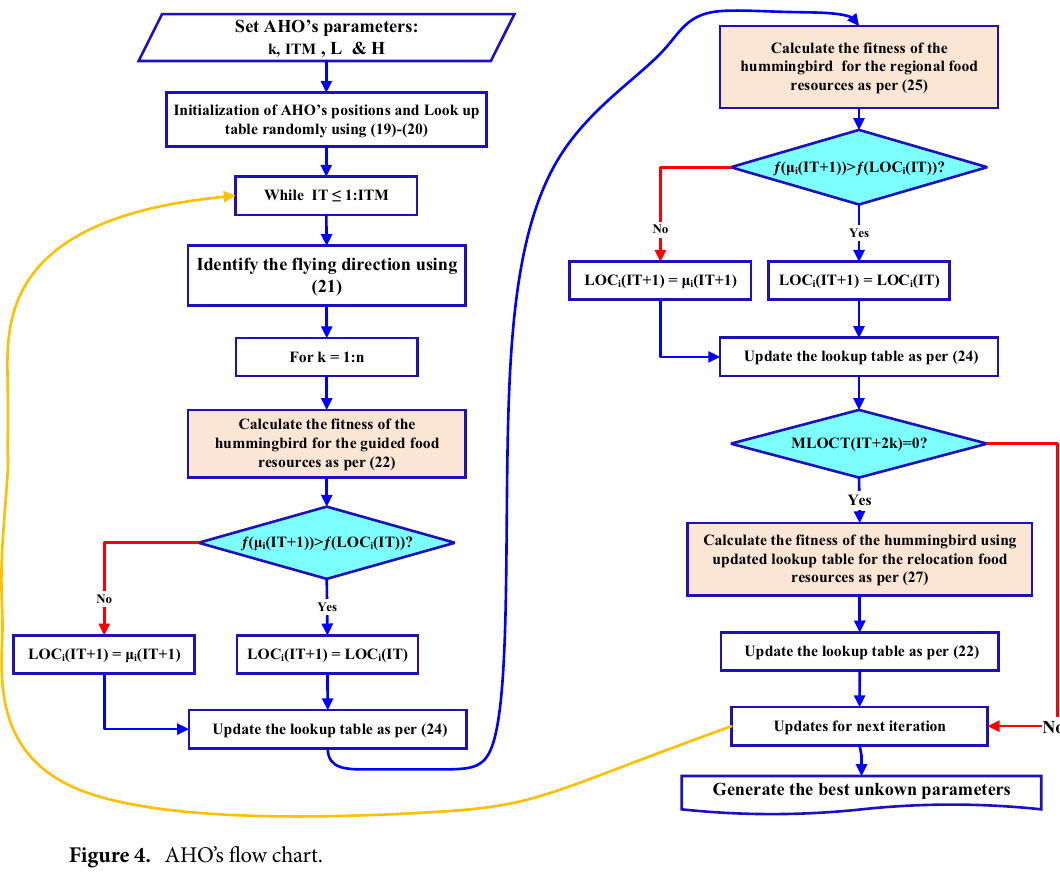
Figure 4. AHO’s flow